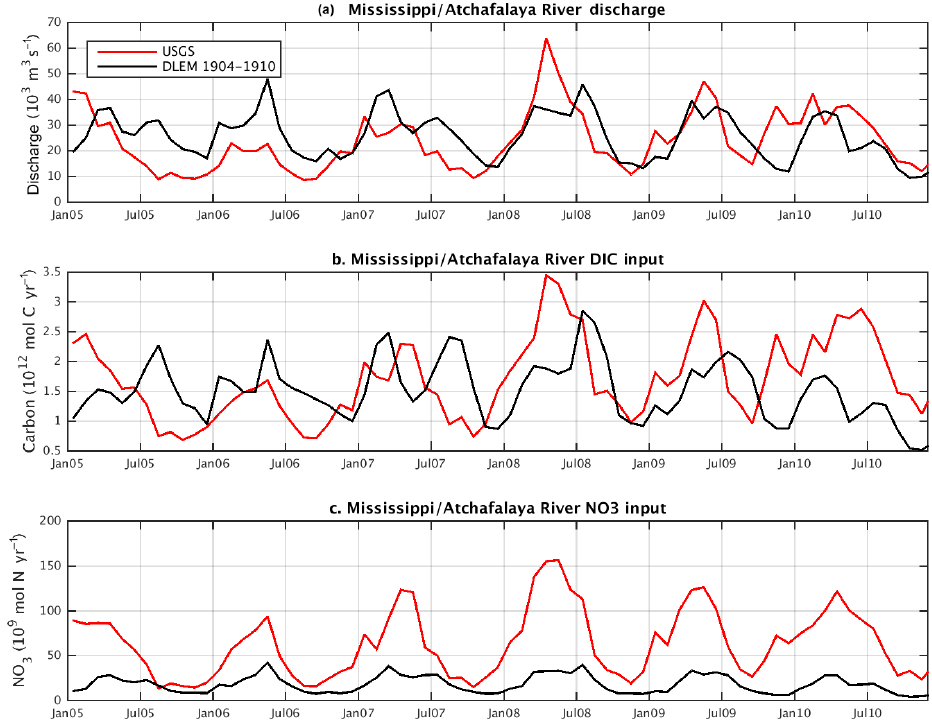
Figure 4. Comparisons between the 2005–2010 riverine DIC and NO 3 conditions observed by USGS (red line) and the 1904–1910 river condition simulated by the Dynamic Land Ecosystem Model (black line; Tian et al., 2015).